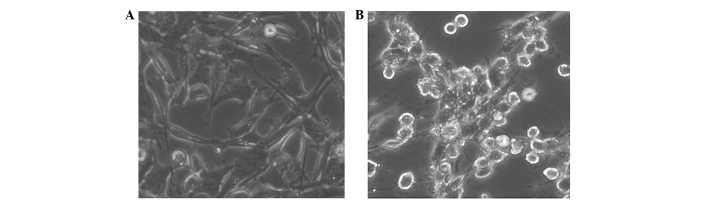
(A) Cells prior to treatment with H2O2. (B) Cells treated with 200 μmol/l H2O2 for 15 min. Magnification, ×400.